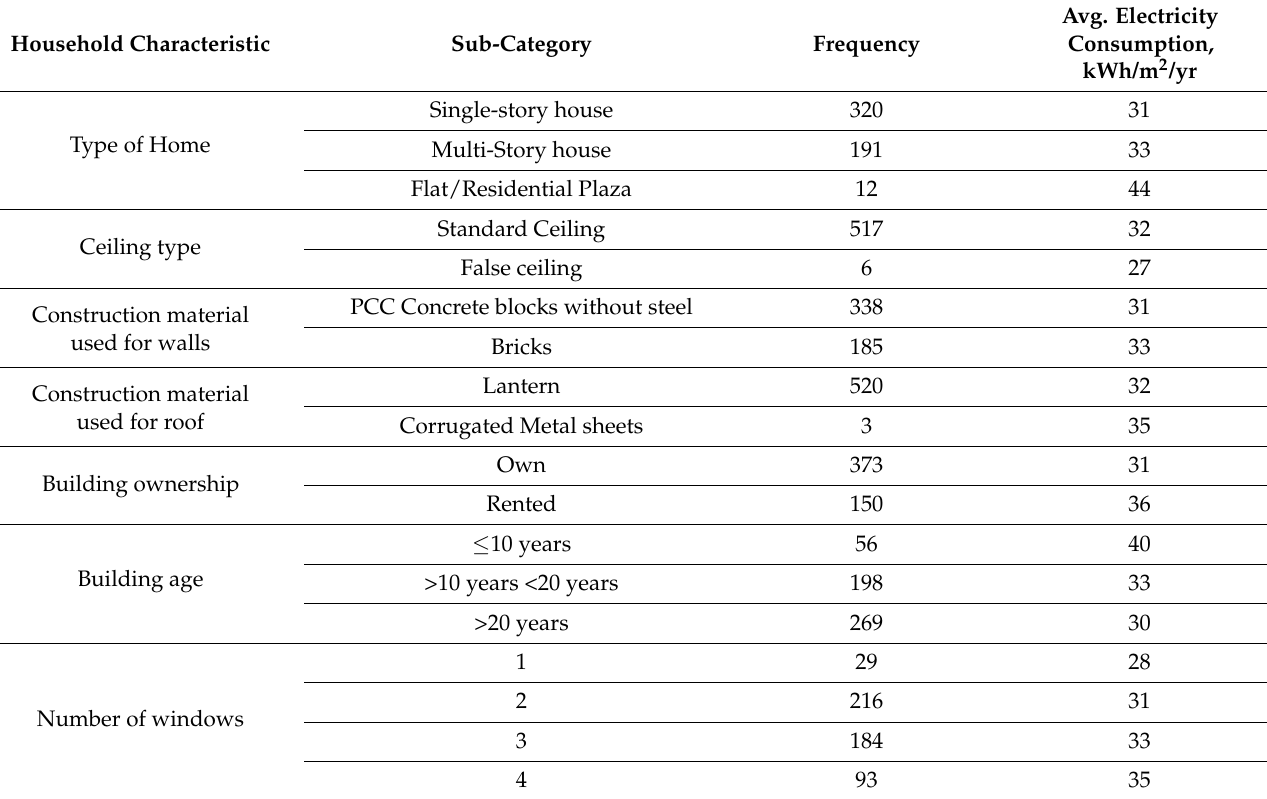
Table 2. Electricity consumption of household characteristics based on